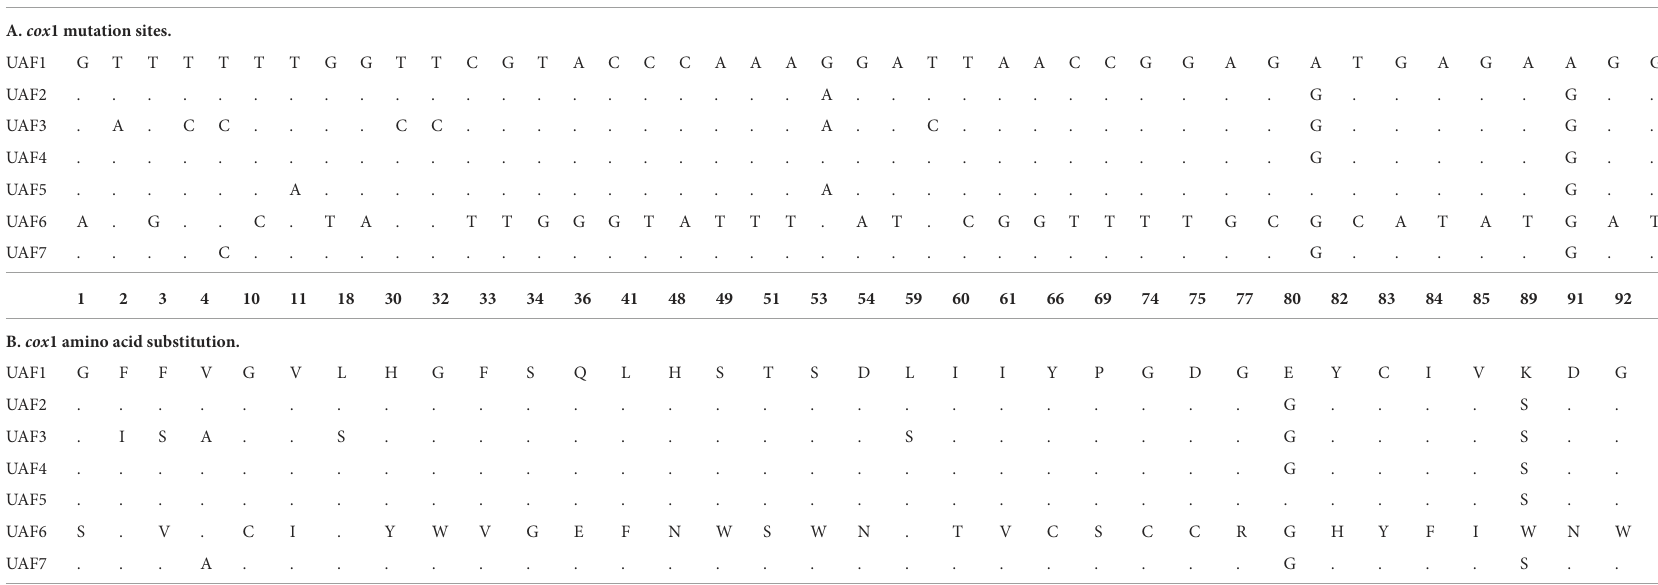
A. cox 1 mutation sites.